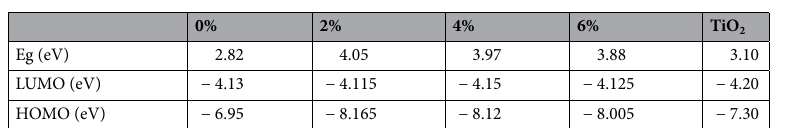
Table 1. Optical and electrochemical properties of SnO 2 @ZnO nanocomposite, different volume ratios of SnO